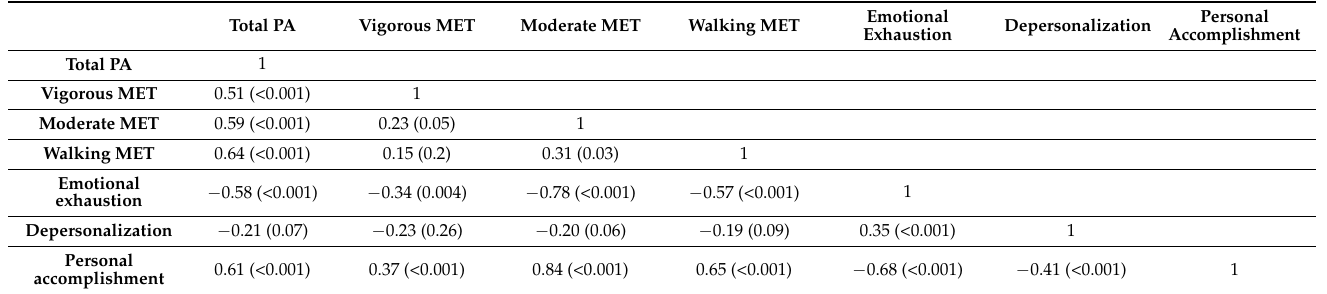
Table 2. Correlations between physical activity (PA) levels and burnout subscales among participants during COVID-19 or before Ramadan.